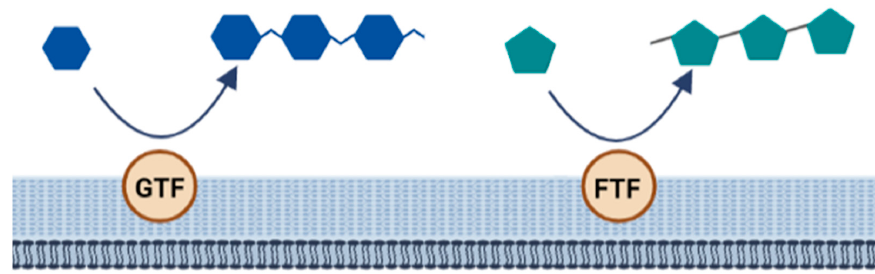
Figure 6. Biosynthesis of homopolysaccharides.